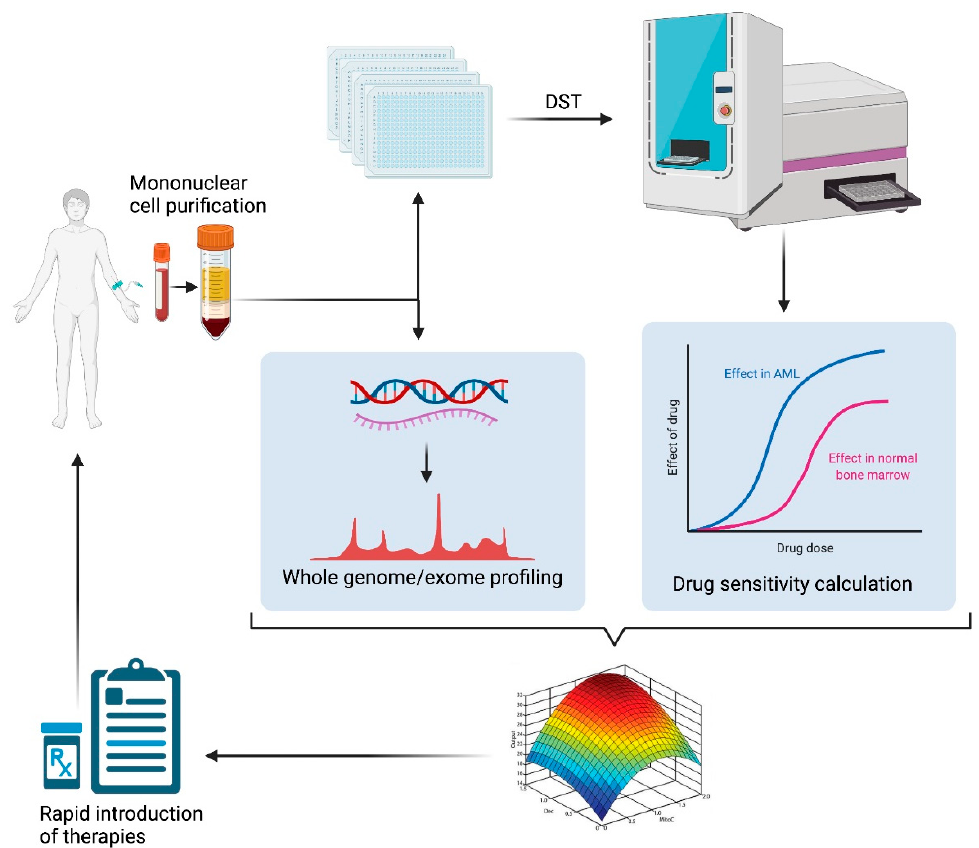
Figure 3. Personalized medicine strategy to tailor treatments for patients with chemotherapy refrac- tory blood cancer. The platform involves (1) in vitro high throughput screening on primary cells from patient samples; (2) deep molecular and genomic profiling of the patients samples; (3) inte- grating drug sensitivity and sequencing data; (4) optimal drug combination and dosage using ex- perimental-analytic AI platform. Parabolic response surface-based map is reproduced with permis- sion from Dr. Edward Chow [56]. This figure is created in BioRender.com (Available online: https://biorender.com/, accessed on 25 February 2022).